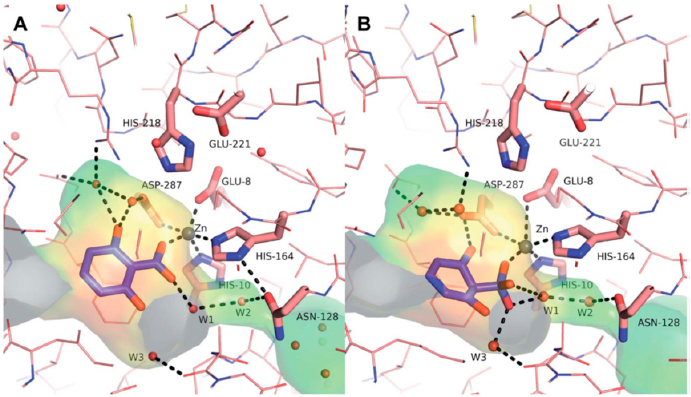
Figure 11. 3D model of the active site of 2,6-DHBD_Rs based on the crystal structure of 2,6-DHBD_Rs (PDB-Code: 2DVU). ( A ): 2,6-dihydroxybenzoate docked into active site; ( B ): Energy minimized docking of the proposed oxyanion intermediate. Dashed black lines show the coordination of Zn 2+ and the hydrogen bonding network. Adapted with permission from [45]. Copyright 2014, Royal Society of